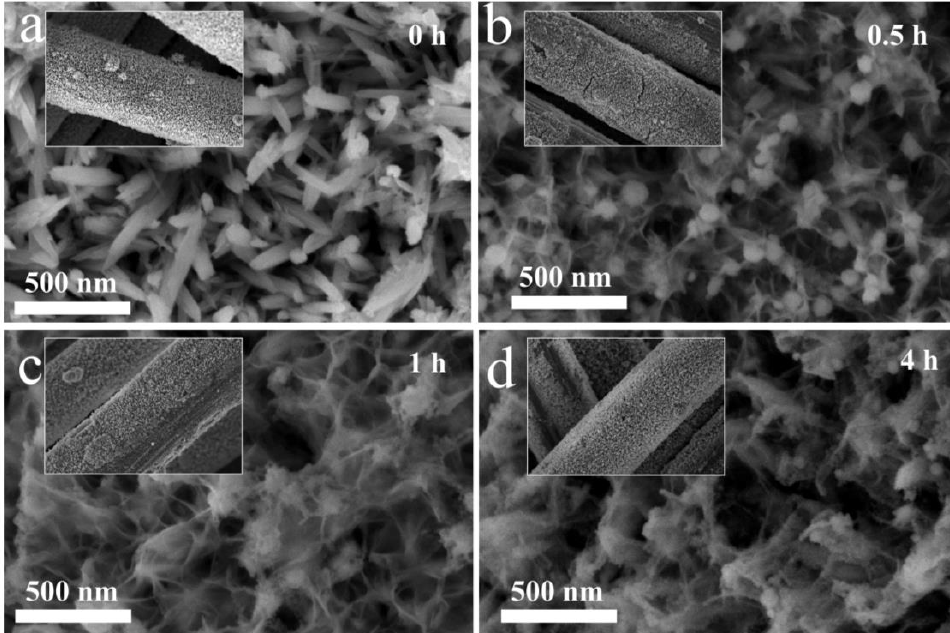
Figure 3. SEM images of D-Fe 2 O 3 /CC electrode prepared using different immersion times: ( a ) pris- tine Fe 2 O 3 , ( b ) D-Fe 2 O 3 -0.5 h, ( c ) D-Fe 2 O 3 -1 h, and ( d ) D-Fe 2 O 3 -4